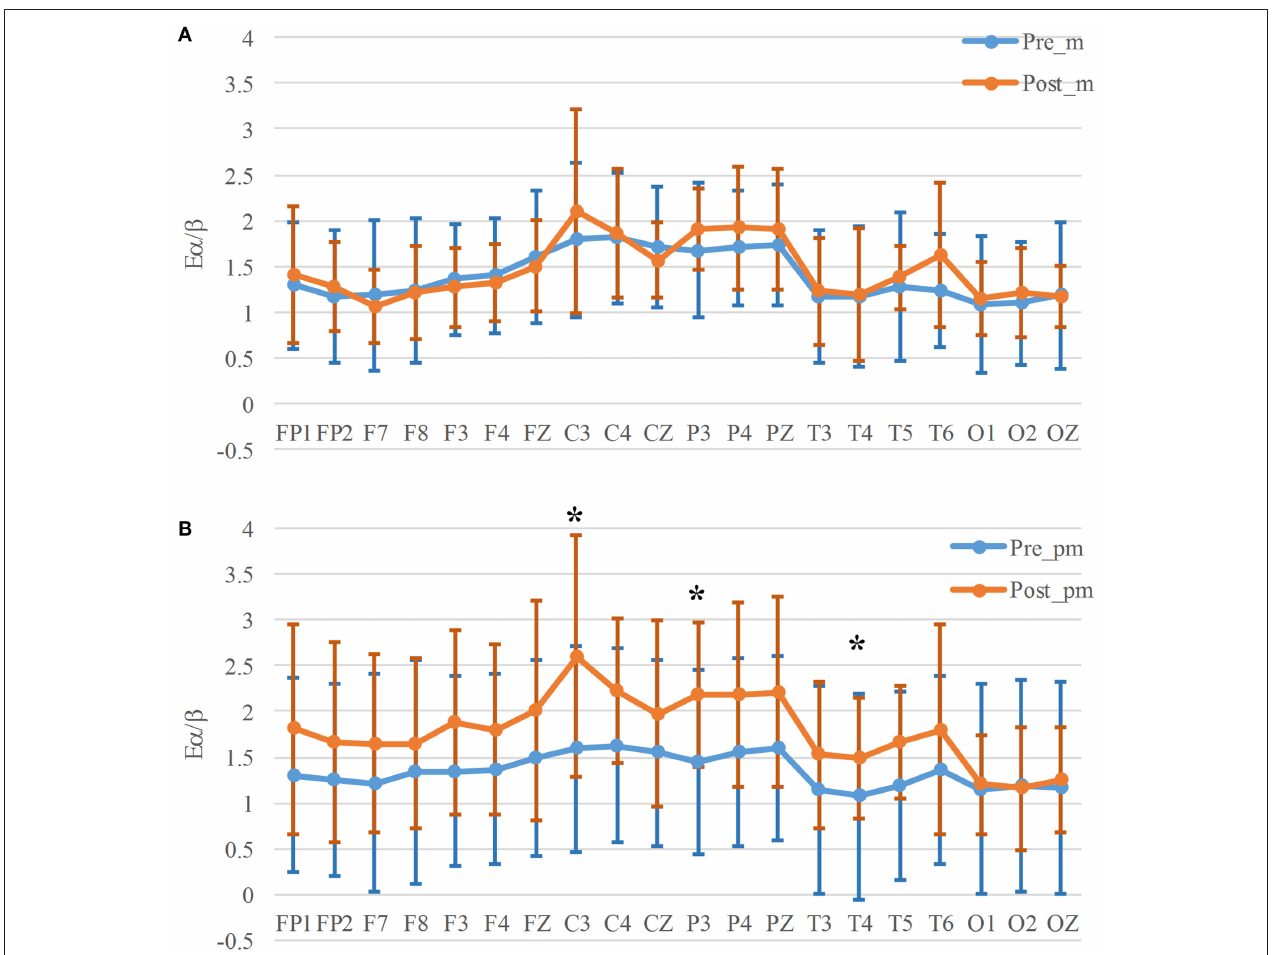
FIGURE 4 | E α/β for mental (A) and physical mental tasks (B). * p < 0.05.